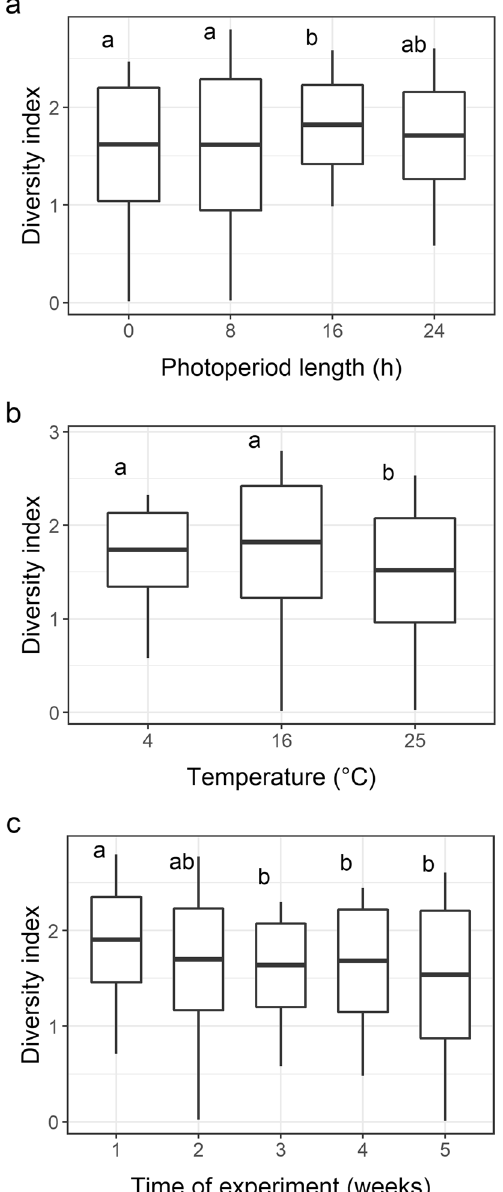
Figure 3. Shannon–Weaver diversity index values: ( a ) at different photoperiod lengths, ( b ) at different temperatures, and ( c ) in successive sampling weeks (1–5). The same letters at the boxes denote lack of significant difference ( P ≥ 0.05) between particular groups according to a post-hoc test (whiskers: minimum and maximum values, box: standard deviation, and line: mean; N = 180). The graph was created in R 4.0.4 under RStudio 1.4.1106 using the ‘ggplot2’ package and the data in